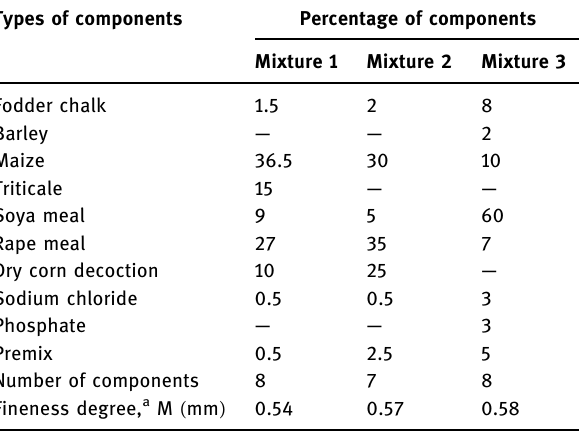
Table 1: Composition and degree of fi neness of the analyzed mixtures Types of